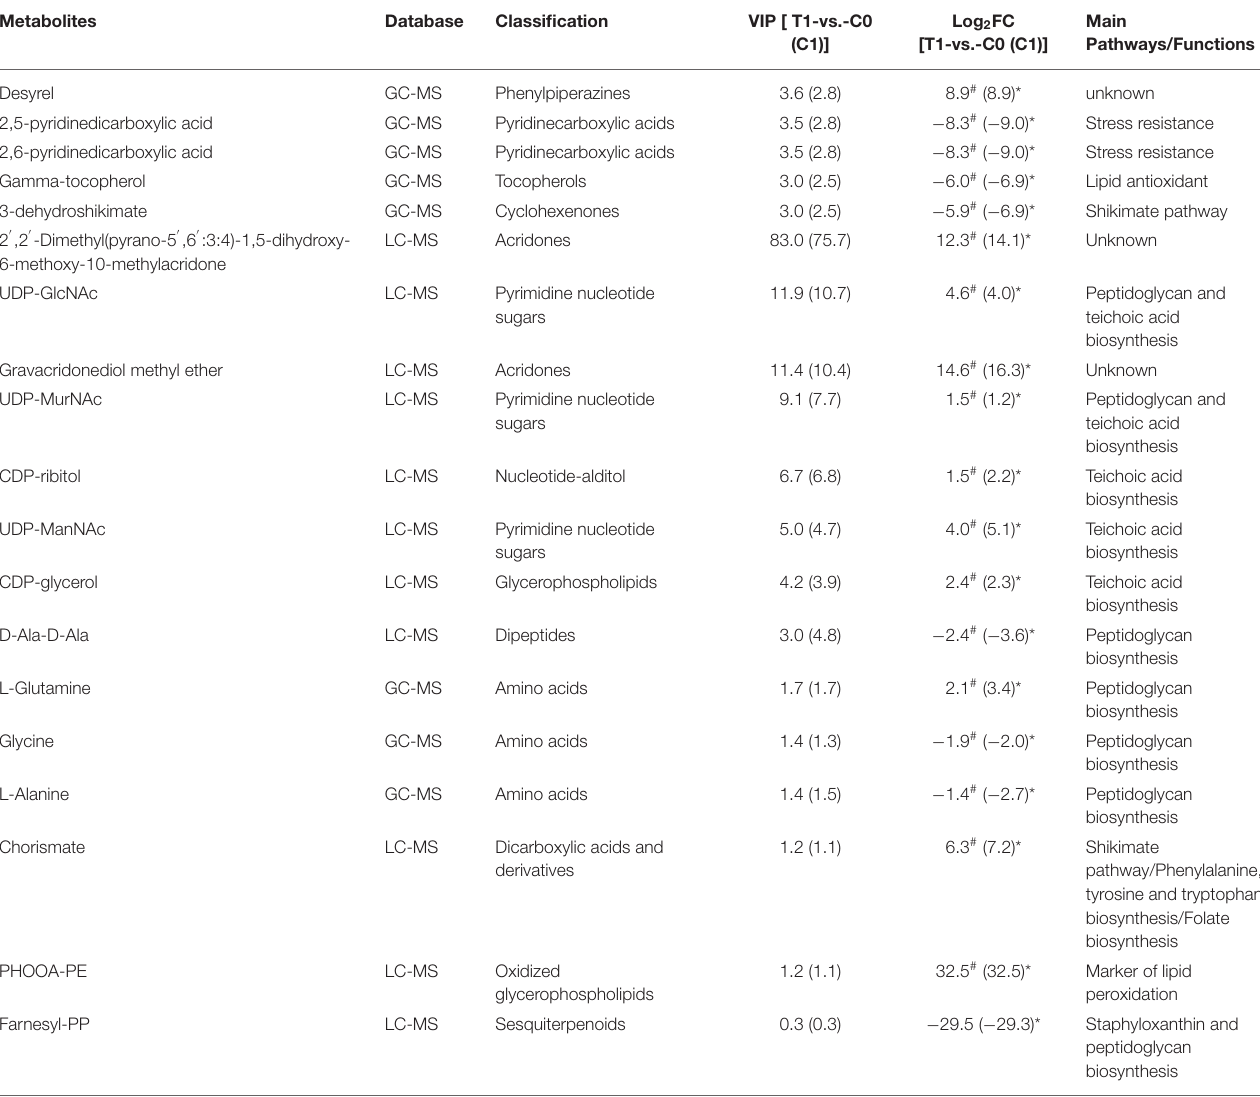
TABLE 2 | The main molecular markers in BBR-exposed S. aureus .